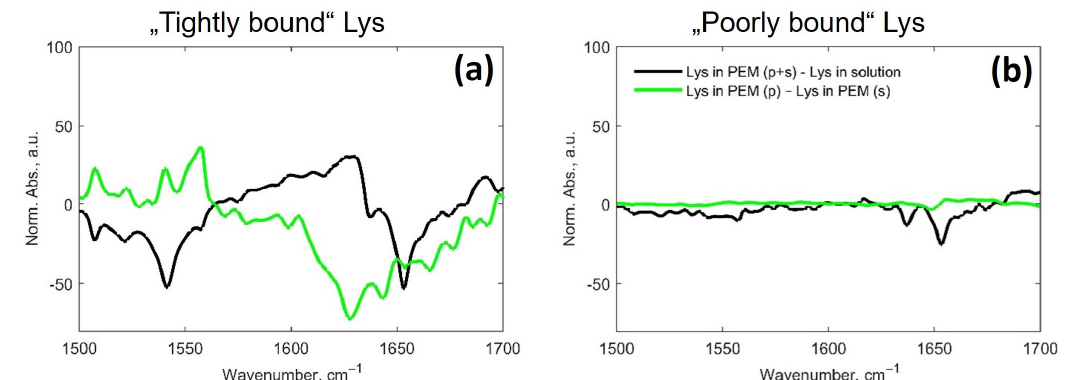
Figure 7. The spectra in black represent the difference between the area-normalized spectrum of the “tightly bound” fraction of Lys in the PEM or “poorly bound” fraction and the spectrum of Lys in solution ( a or b , respectively). Spectra in green represent the difference between area-normalized p and s polarizations spectra of the “tightly bound” ( a ) and the “poorly bound” ( b ) fractions of Lys.